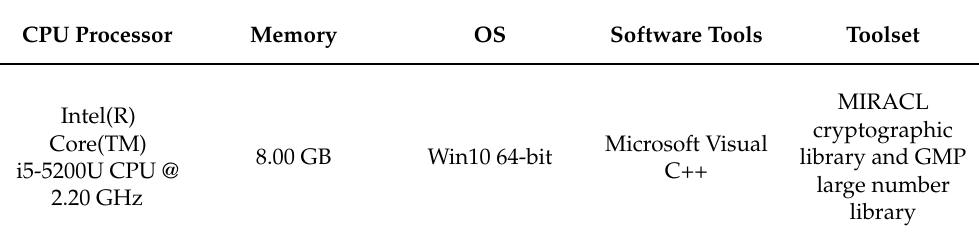
Table 4. The experimental environment and